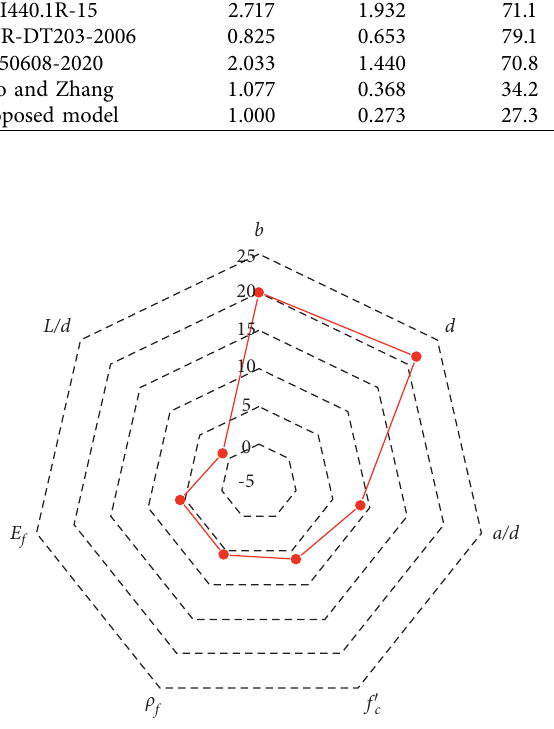
Figure 5: Effect of each parameter on the shear capacity (in